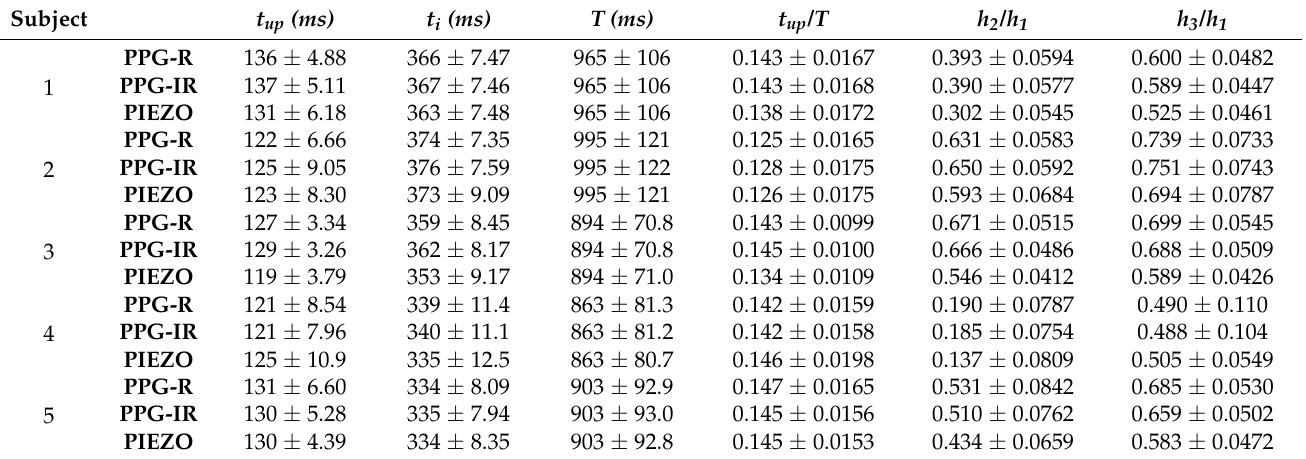
Table 5. Morphological parameters extracted from PW signals acquired by FCG and PPG sensors.